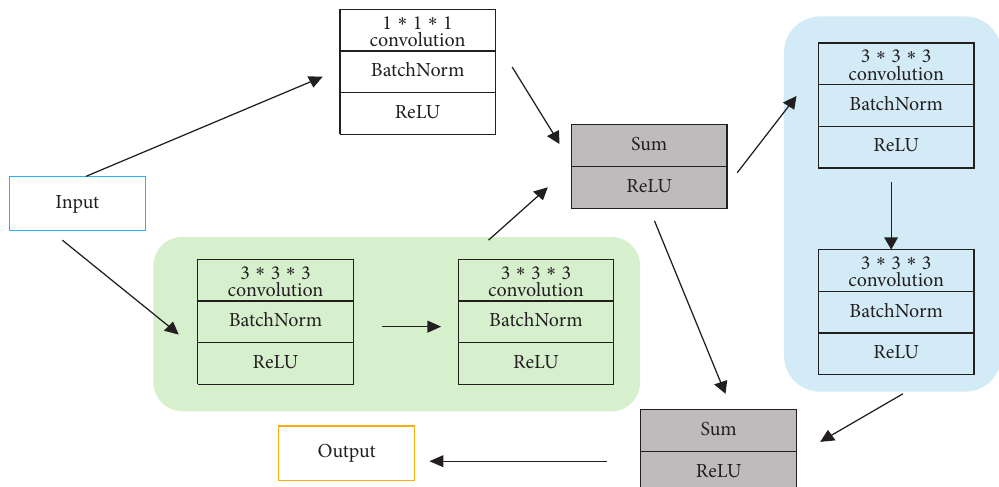
Figure 3: Browse music timeline by artist.